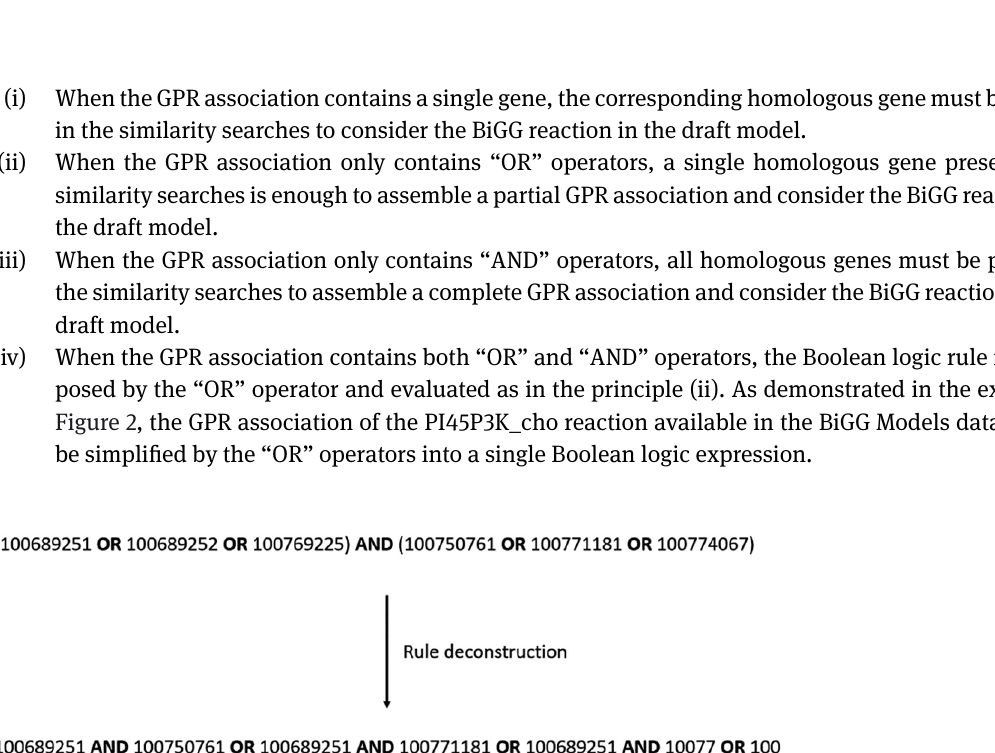
Figure 1: BiGG integration tool workflow implemented in merlin . Users have access to BIT within merlin ’s graphical interface. The genome sequence fasta file is submitted to the BIT webserver for an organism of interest. A bidirectional BLAST similarity search is performed against the protein sequences available at the BiGG models database (1). This process allows the identification of homologous genes in the database. Then, Gene-Protein-Reaction (GPR) associations are elaborated based on the homologous genes and reactions available in the BiGG models database (2). Identified reactions are further integrated and validated based on the associated metabolites, namely reactants and products (3). Finally, the model can be exported or integrated into merlin ’s workspace.